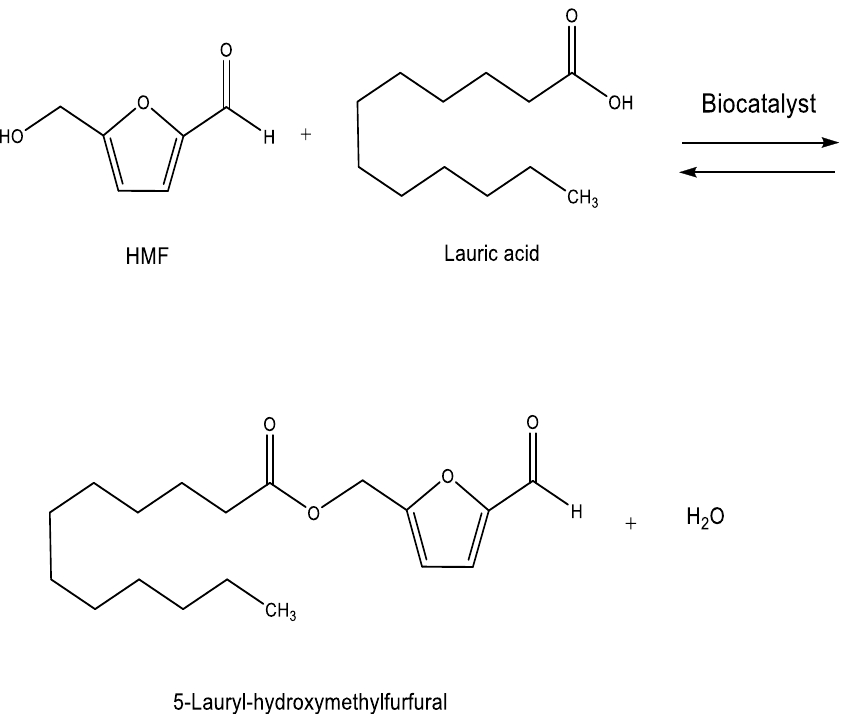
Figure 1. Enzymatic esterification of HMF with lauric acid to produce 5-lauryl- hydroxymethylfurfural.